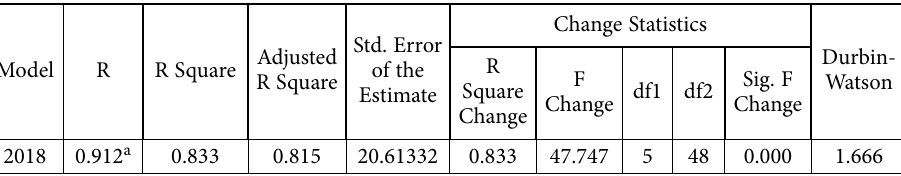
Table 9. Seasonal sustainability function for 2018 Model R R Square